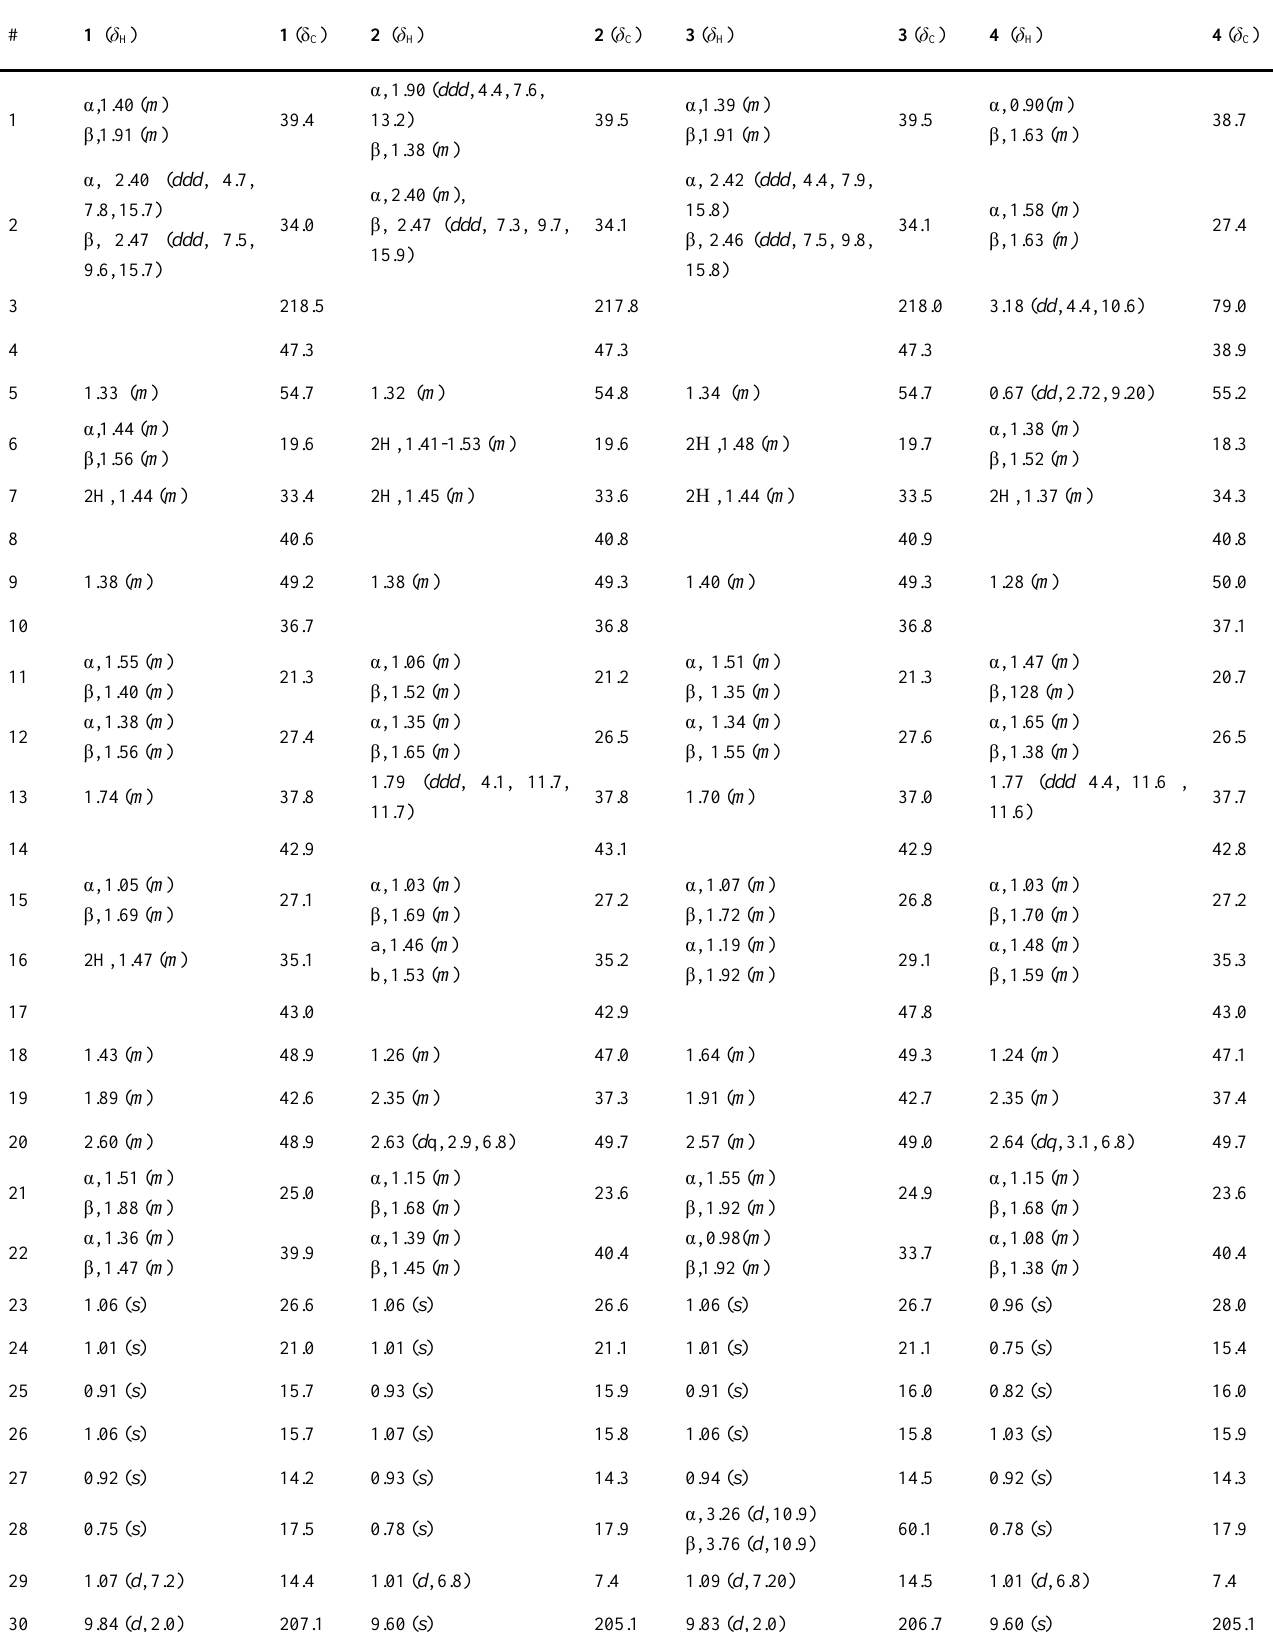
Table 1. NMR spectral data for metabolites 1 – 4 a